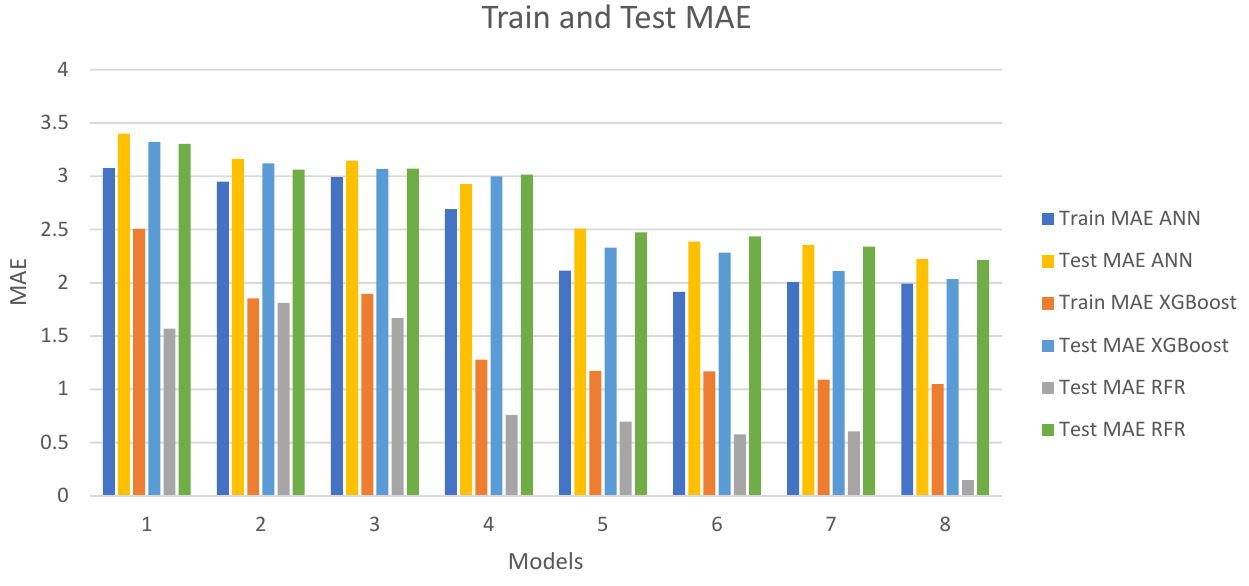
Figure 11. Train and test MAE for all methods.